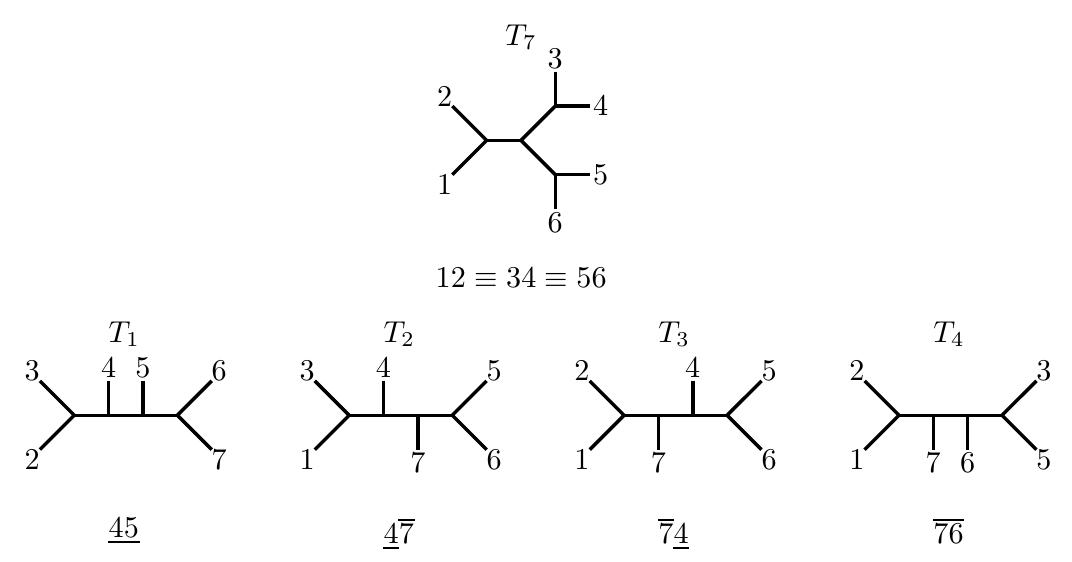
Figure 10 . Notation used to identify planar trees in k = 3 , n = 7 . Top: planar snowflakes can be identified by any of their cherries. Bottom: planar Caterpillar trees can be identified by their two internal lengths and how they are planarly related to the cherries. Again, the position of any tree (given by T a ) in the collection determines the label not present in the